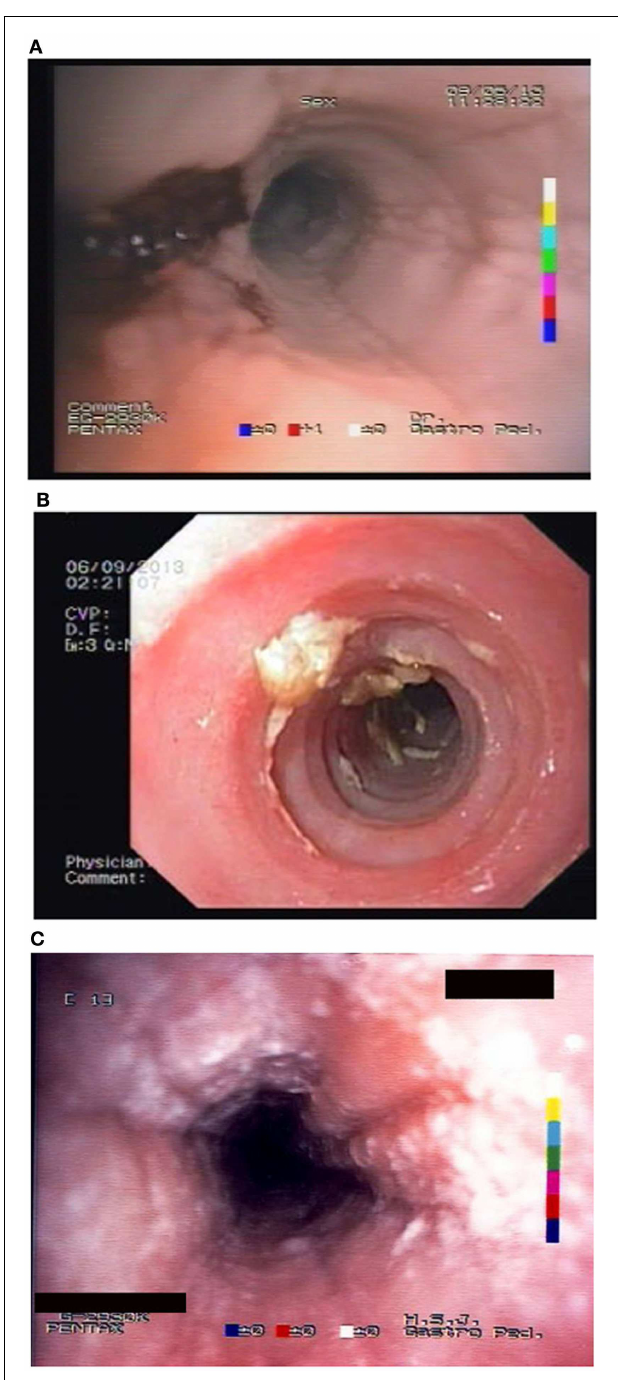
FIGURE 1 | Endoscopic appearance of EoE showing (A) friability of the mucosa and easy bleeding; (B) trachealisation of esophagus with remains of recent food impaction; and (C) edema with furrows and white spots of eosinophil granulomas .